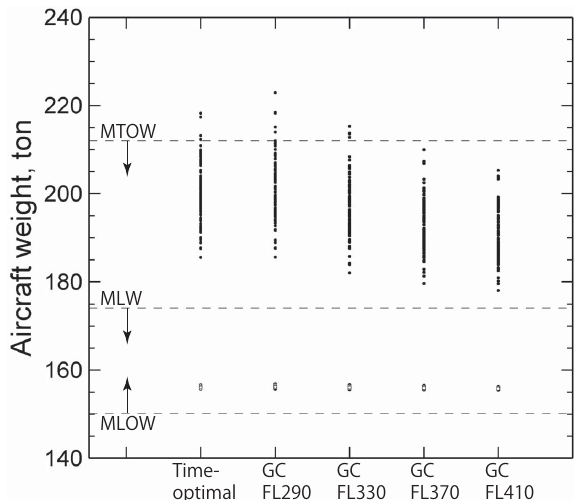
Figure 21. Comparison of aircraft weights with structural weight limits (MTOW and MLW) and one specified weight limit (MLOW). The aircraft weights of the 103 flights for the time-optimal and great circle cases are plotted. ◦ : aircraft weight at the last waypoint ( m n ). • : aircraft weight at the first waypoint ( m 1 ). The description wp of the limits is shown in Table